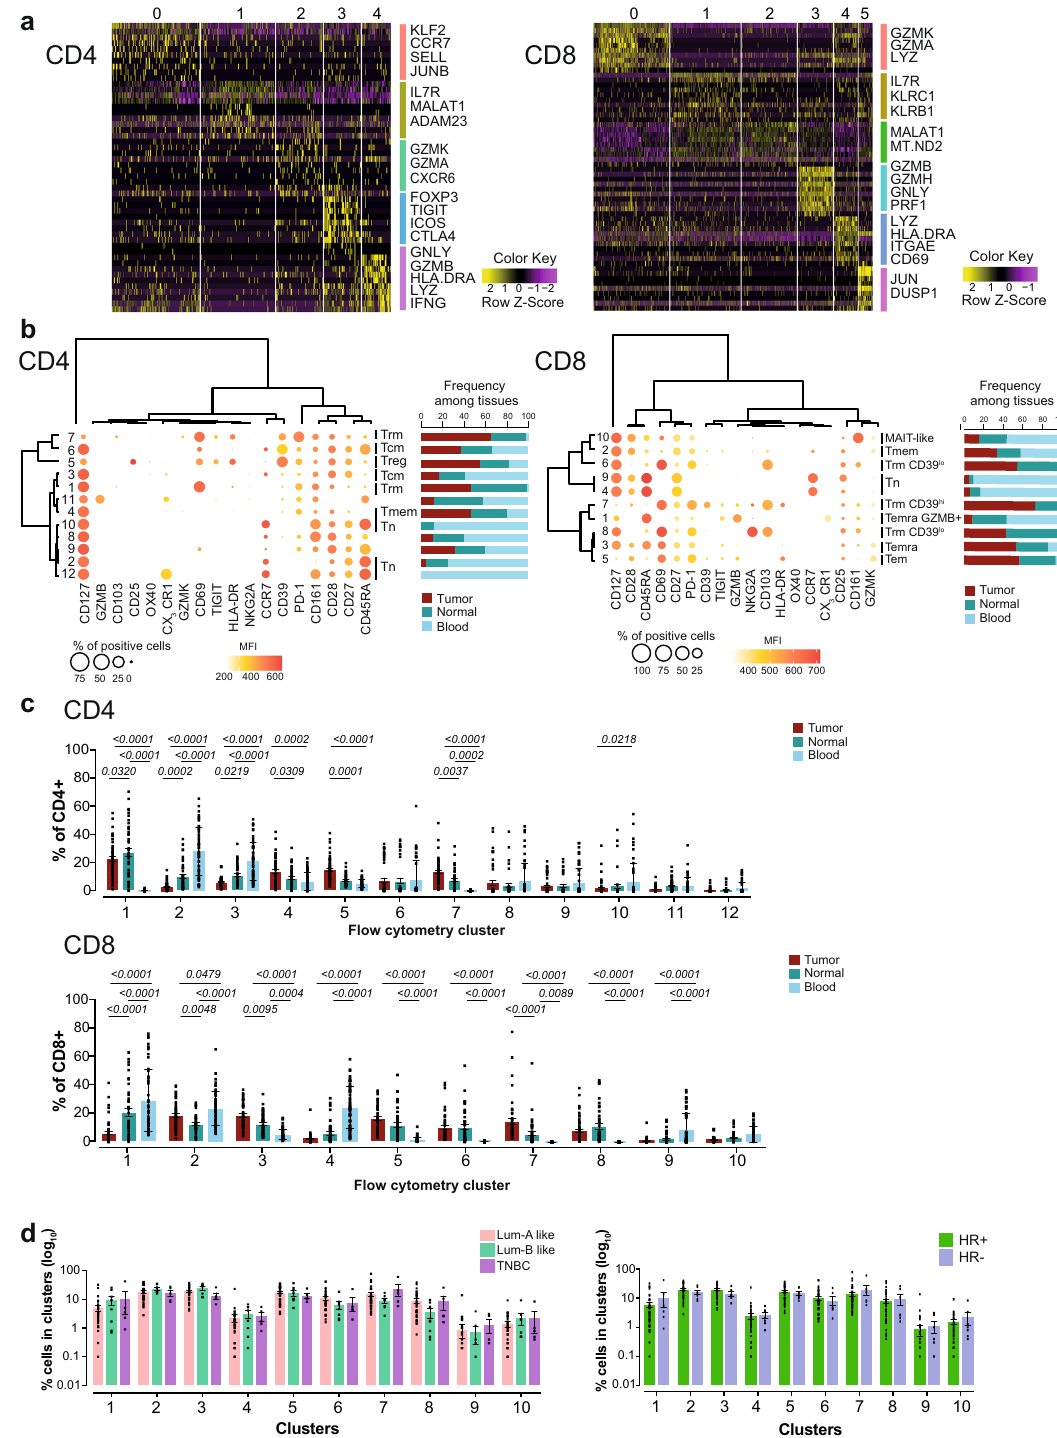
Fig. 1 Breast cancer (BC) immune in fi ltrates are enriched in Trm cells. a Heatmaps showing single-cell gene expression by T-cell clusters from tumor- in fi ltrating CD3 + cells from BC patients ( n = 475 cells for CD4 + and 1167 cells for CD8 + ). Signature genes of the speci fi c clusters are indicated. b Balloon plot maps showing the percent expression and the median fl uorescence intensity (MFI) of speci fi c markers (columns) in discrete PhenoGraph clusters (rows) as identi fi ed from the analysis of 54 patients. Hierarchical metaclustering grouped markers and clusters with similar immunophenotypes. Bar plots show the percent frequency of each cluster among different tissues (tumor, normal tissue, and peripheral blood). Treg CD4 + regulatory T cells, Trm tissue-resident memory, Tcm central memory, Temra effector memory reexpressing CD45RA, MAIT mucosal-associated invariant T, Tem effector memory. c Bar plots showing the frequency depicted as mean ±SEM of CD4 + and CD8 + T-cell PhenoGraph clusters in peripheral blood, normal breast tissue, and tumor samples from data obtained in b . Numbers indicate the exact p values for tumor vs. peripheral blood or normal tissue samples; two-way ANOVA with Bonferroni post hoc test. d As in c , but among luminal A-like, luminal B-like, and triple negative breast cancer (TNBC) biological subtypes and among subtypes according to positive or negative expression of hormone receptors